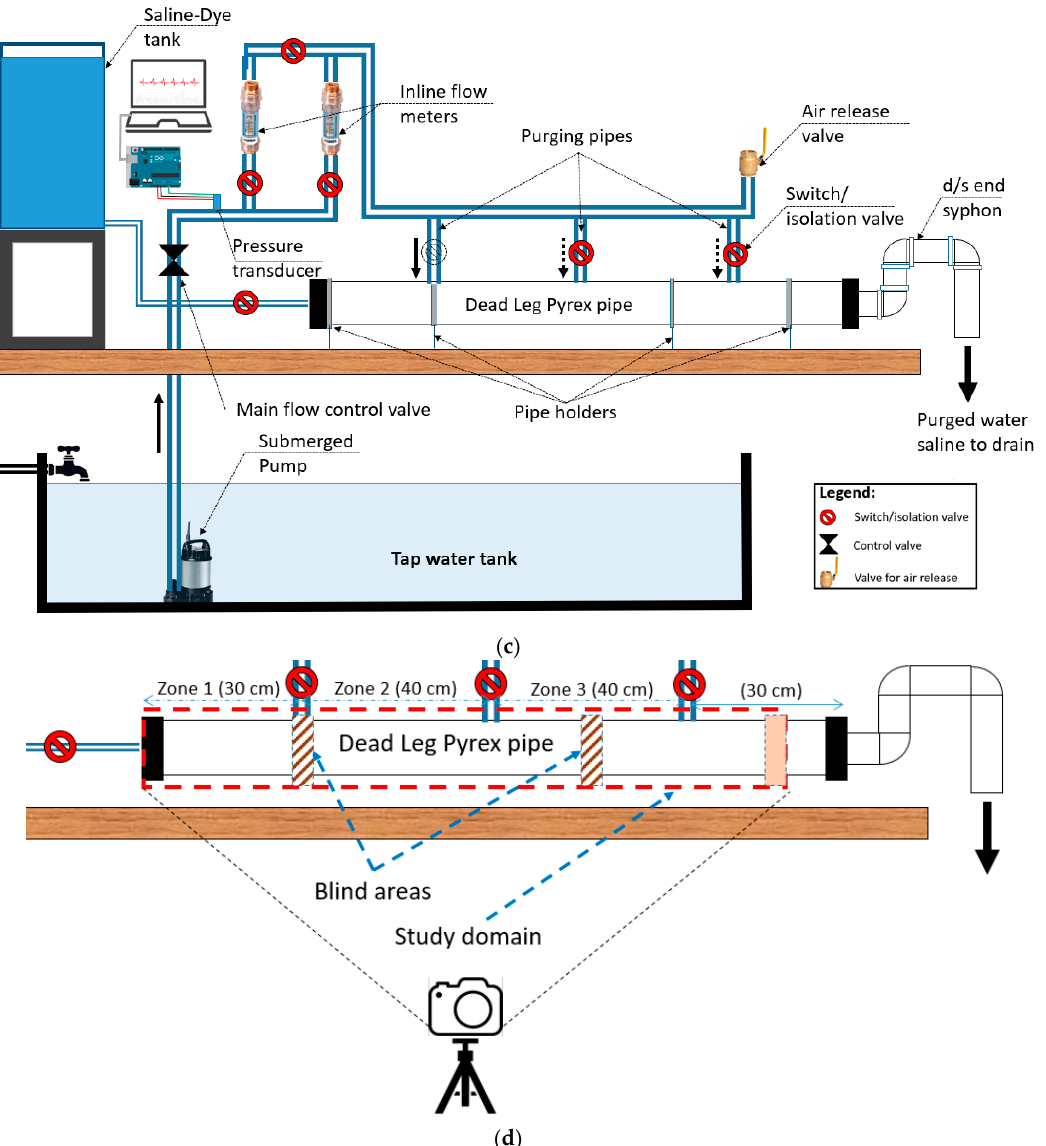
Figure 3. Experimental Setup. ( a ) Lab. Experiment Setup; ( b ) Light streaks (zoom in of dashed frame shown in Figure 3a); ( c ) Schematic of Experimental Setup; ( d ) Study domain and different pipe zones for the dead leg pipe.